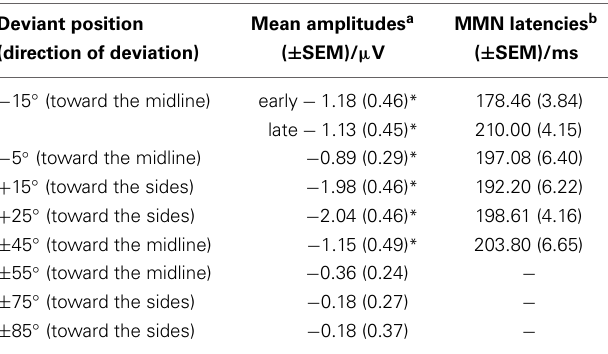
Table 1 | Mean MMN amplitudes and latencies for the 8 deviants measured at electrode